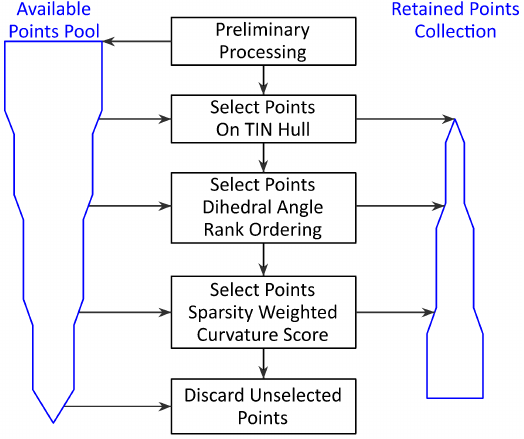
Figure 3. Data and process flow chart for Curvature Weighted Decimation.